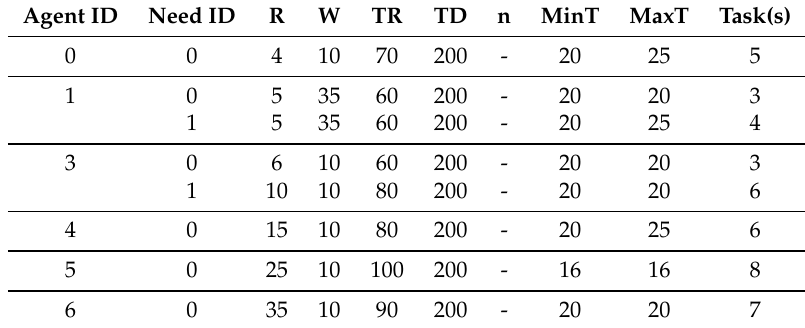
Table 9. Agents’ needs for Scenario